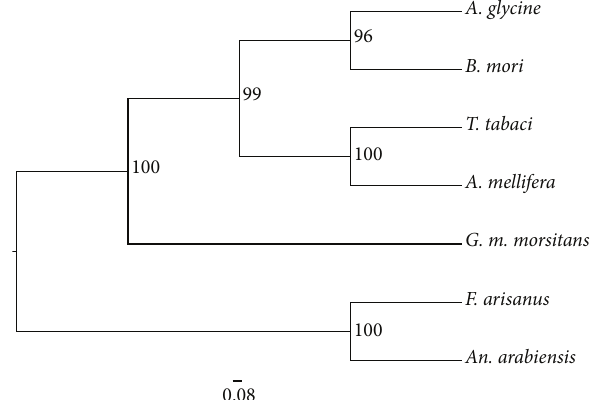
Figure 3: Amidpoint rooted maximum likelihood generated from 28S rRNA sequences for representative species in five major insect orders. The cladogram was generated using PhyML with 100 bootstrap replicates. Node labels show support bootstrap